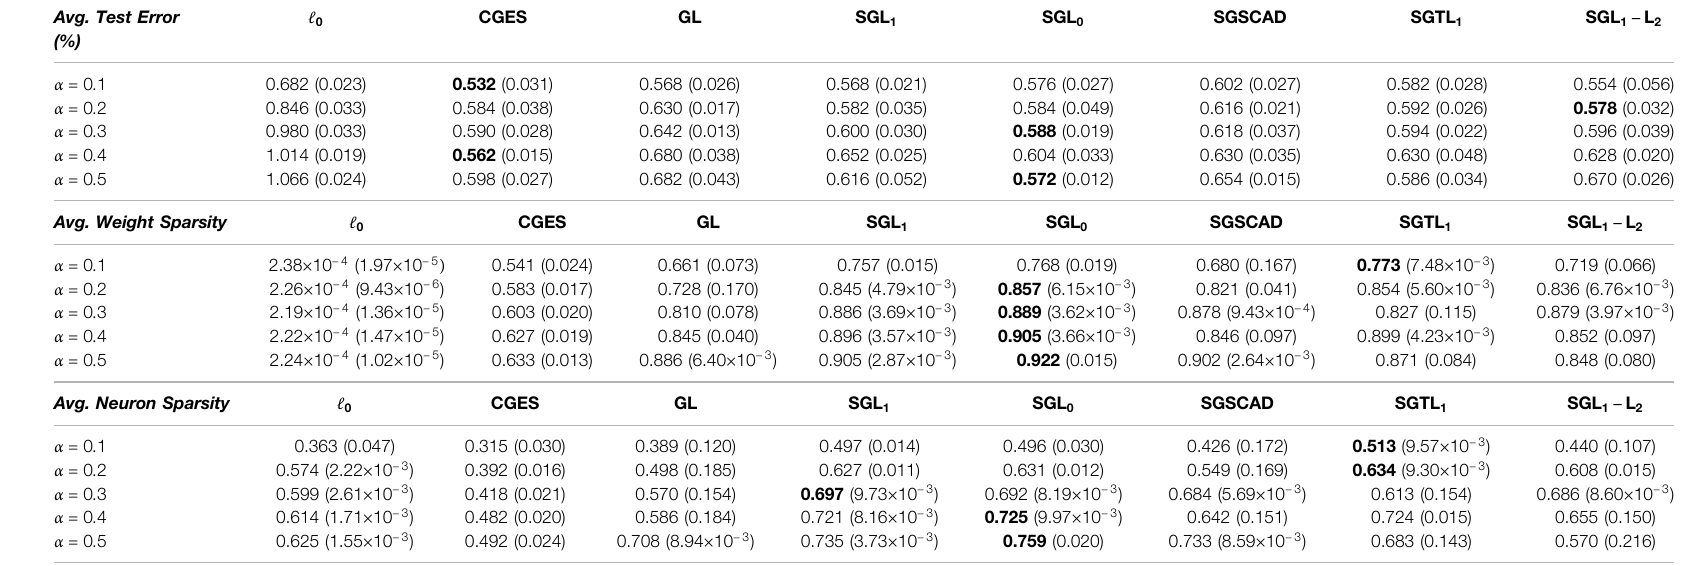
TABLE 3 | Average test error, weight sparsity, and neuron sparsity of Lenet-5 models trained on MNIST with lowest test errors across 5 runs. Standard deviations are in parentheses. Avg. Test Error (%)